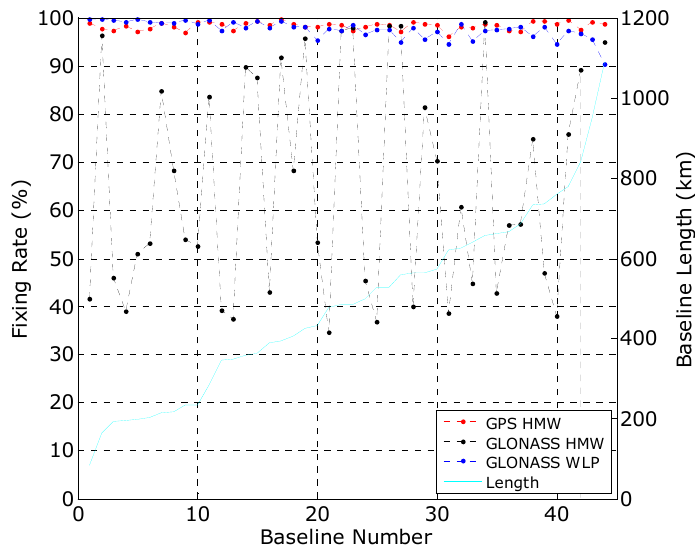
Figure 7. Fixing percentages of the ionospheric-free ambiguities for all baselines. The results show that the proposed method can achieve fixing rates for GLONASS that are comparable to those of GPS.